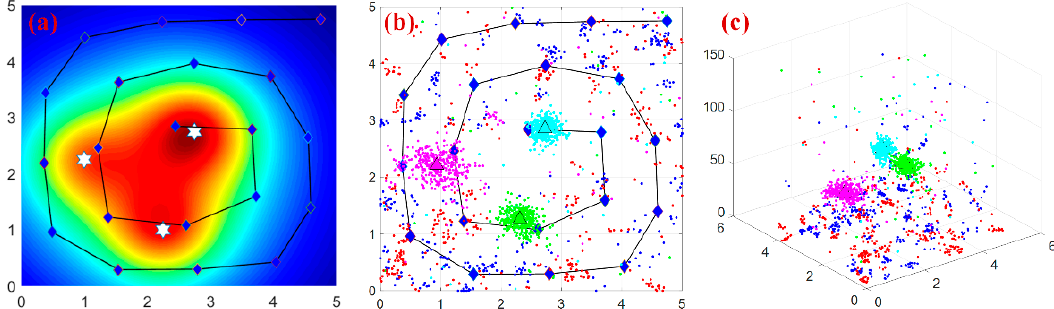
Figure 6. The simulation scenario for 3 radiation sources localization. ( a ) The cloud chart of theoretical mixed radiation field. ( b , c ) The simulation interface and estimated results of the five-layer PSPF algorithm (2D & 3D).